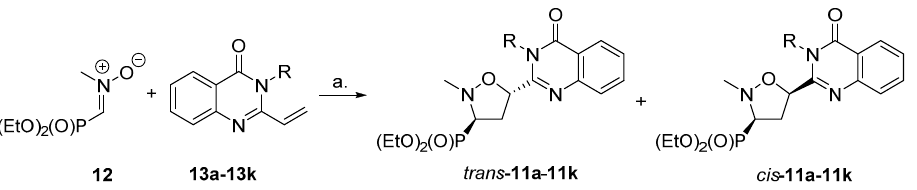
Scheme 3. Synthesis of Isoxazolidines cis - 11a – k and trans - 11a – k . Reaction and conditions : a. toluene, 70 °C, 24 h. Table 1. Isoxazolidines trans - 11 and cis - 11 obtained according to Scheme 3.